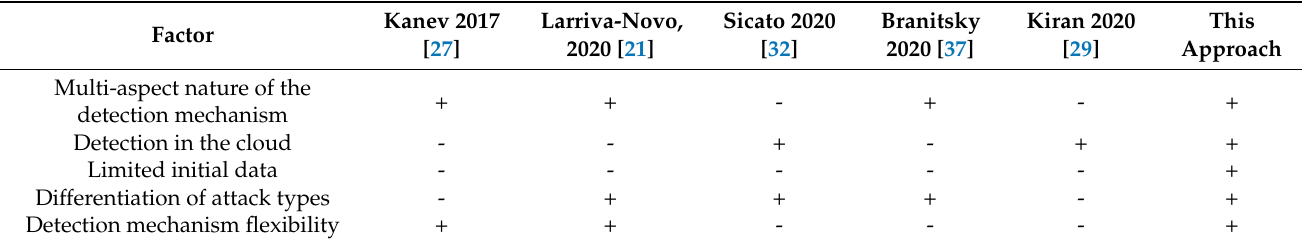
Table 6. Comparison with relevant approaches and